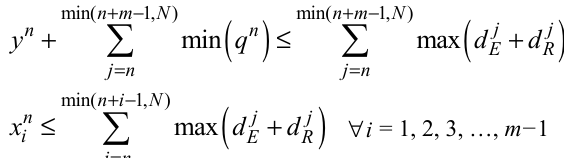
Blood service center